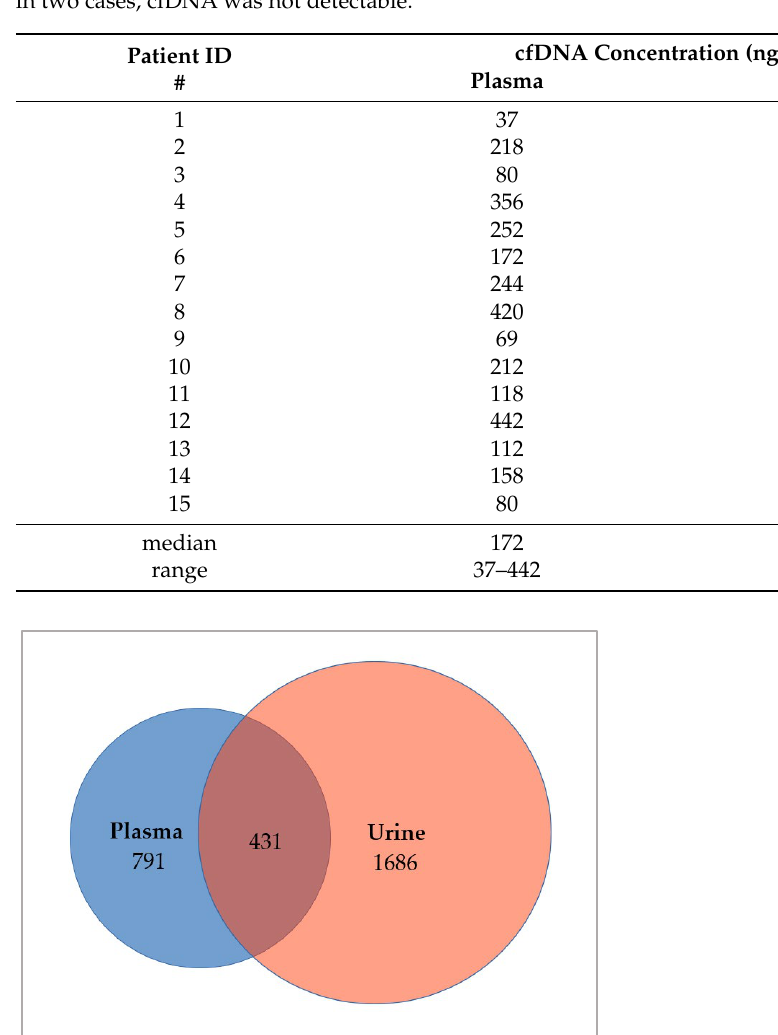
Table 2. cfDNA concentrations from matched plasma and urine samples of 15 TNBC patients prior to surgical tumor resection in ng/mL. The median cfDNA concentration from 4 mL plasma eluted in 20 µ L ultraclean water was 172 ng/mL, ranging from 37–442 ng/mL. The median cfDNA in two cases, cfDNA was not detectable.